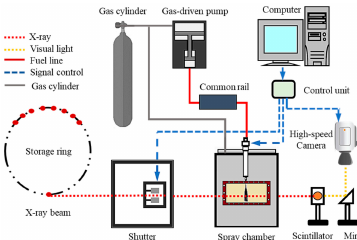
Figure 1. Experimental setup for the X-ray phase-contrast